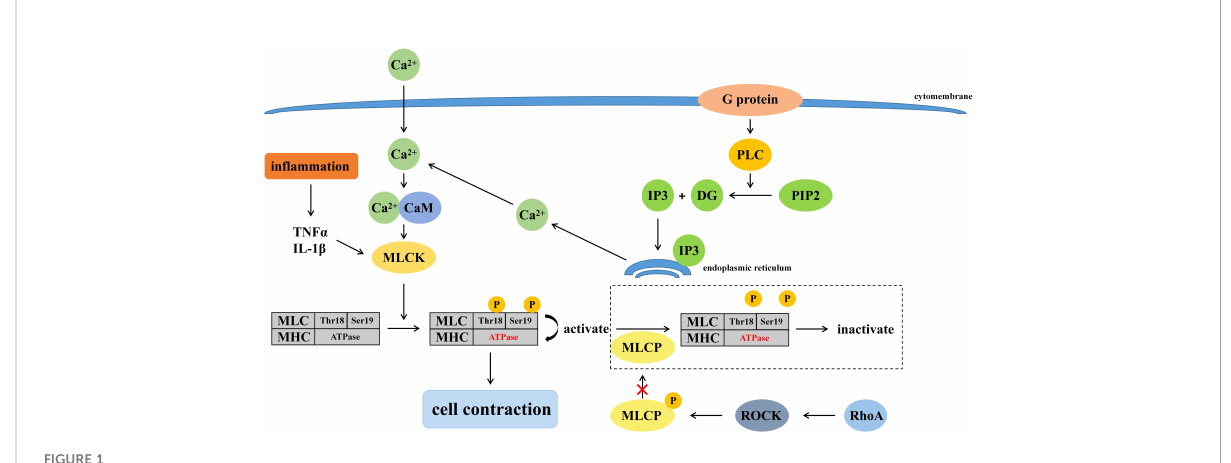
FIGURE 1 Mechanisms of cell contraction induced by